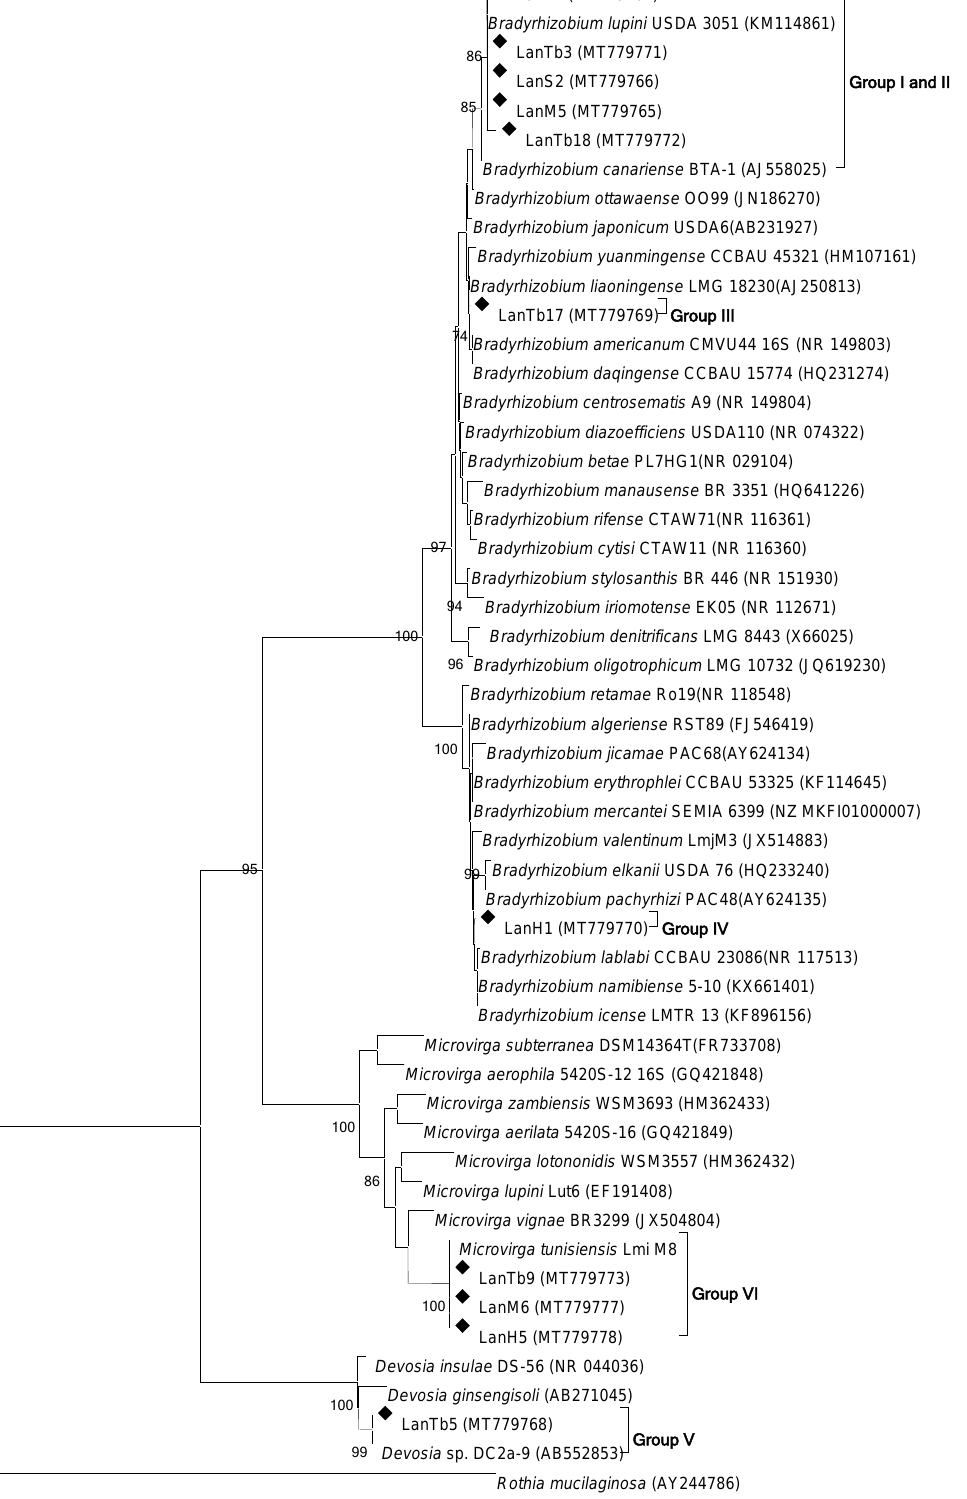
Figure 3. Neighbor-joining phylogenetic tree based on 16S rRNA sequences of Tunisian isolates and reference strains. Black diamonds ( (cid:117) ) indicate Tunisian strains. Bootstrap values using 1000 replicates are indicated at branching points. Bar 0.02 estimated